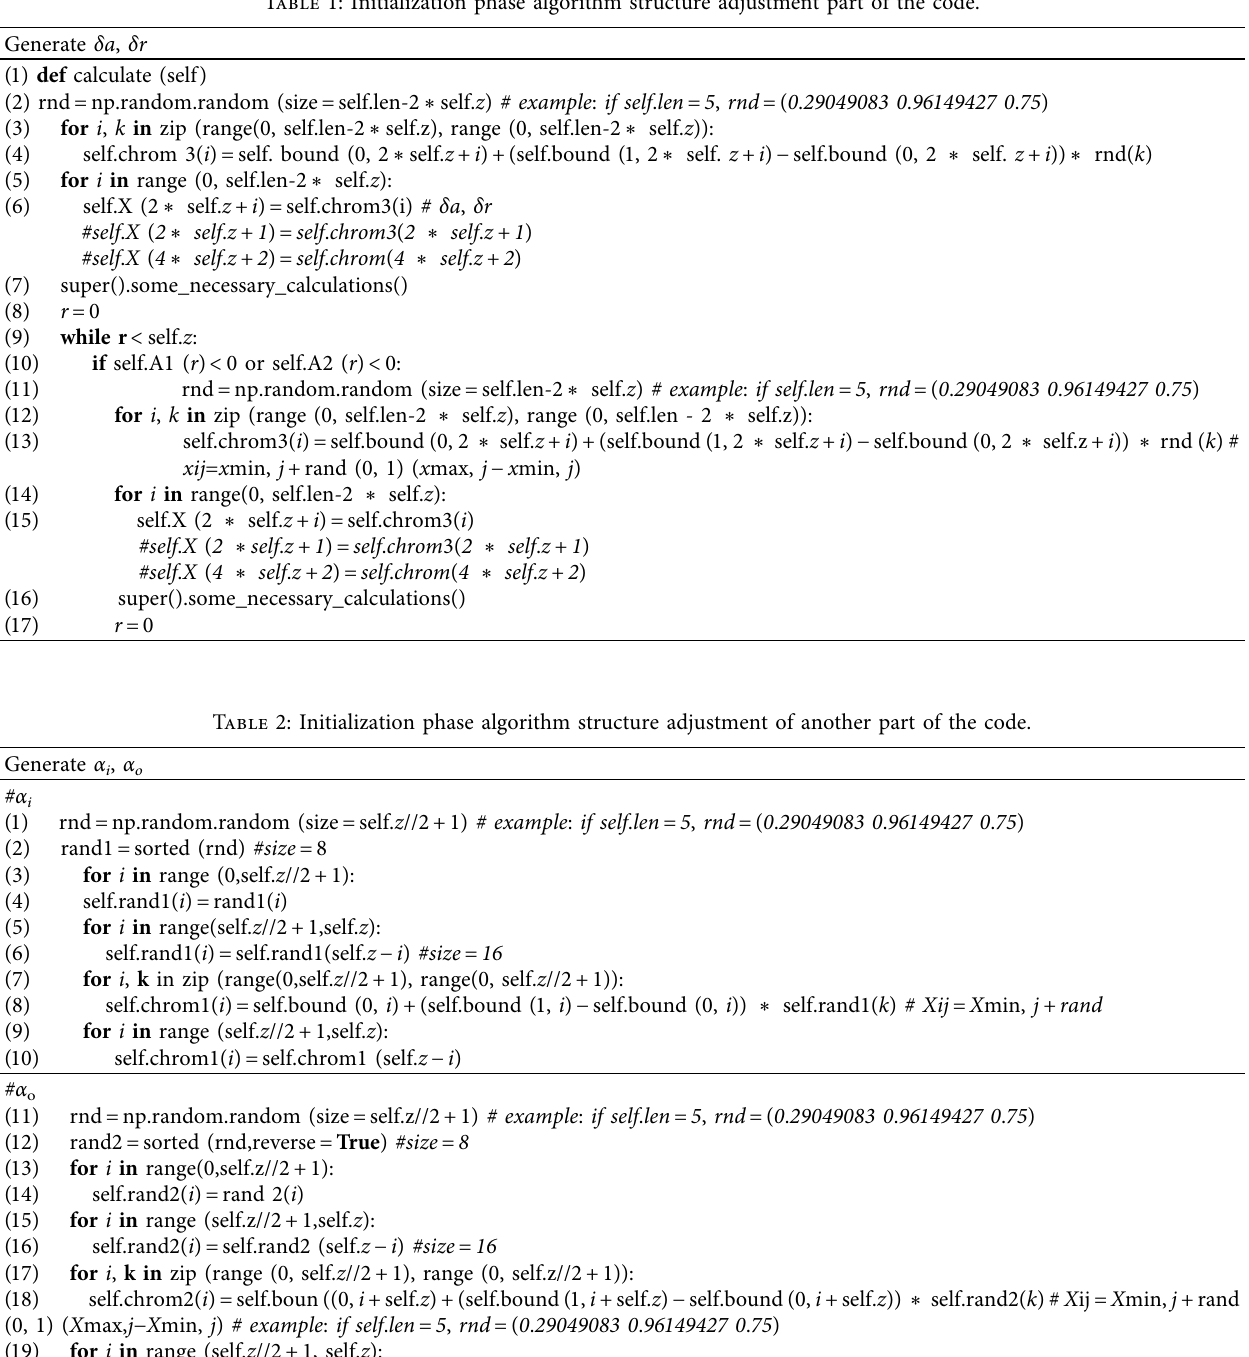
Table 1: Initialization phase algorithm structure adjustment part of the code.